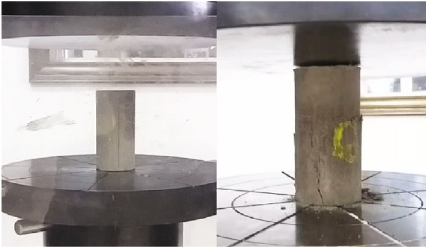
Figure 3: Rock mechanics test.